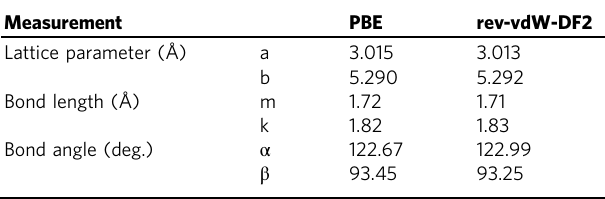
Table 1 Lattice parameters of HB sheet calculated with PBE and rev-vdW-DF2 exchange-correlation